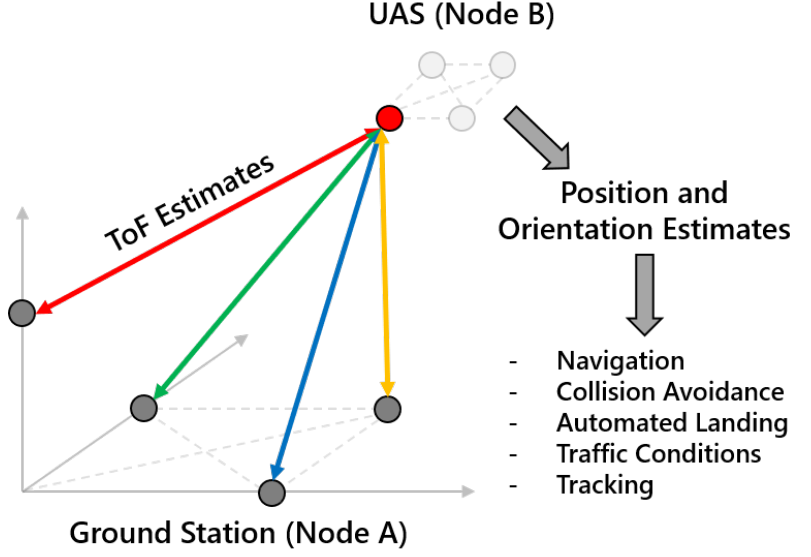
Figure 1. Example multi-antenna two-way ranging (TWR) system with a 4-antenna ground user A and 4-antenna aerial user B . By measuring the distance between each antenna pair (4 of which are depicted above using different colors to denote unique links), we can estimate the relative position and orientation of each user, enabling a wide variety of distributed airborne applications. We derive bounds on the performance of these estimators as a function of the number of antennas, platform geometry, and geometric dilution of precision